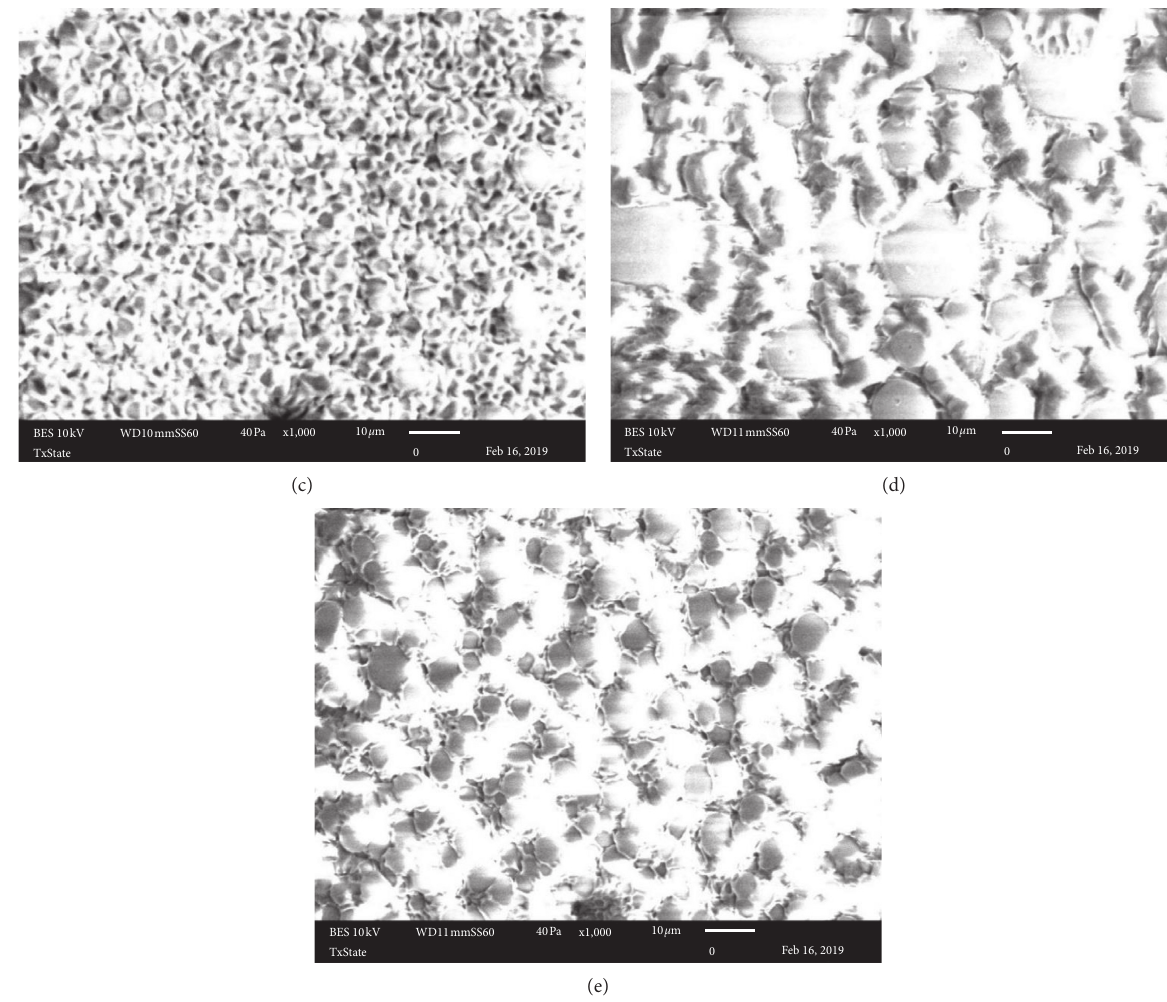
Figure 14: ESEM images at original state: (a) SIS 0%, (b) SIS 5%, (c) SIS 10%, (d) SIS 15%, and (e) SIS 20%.